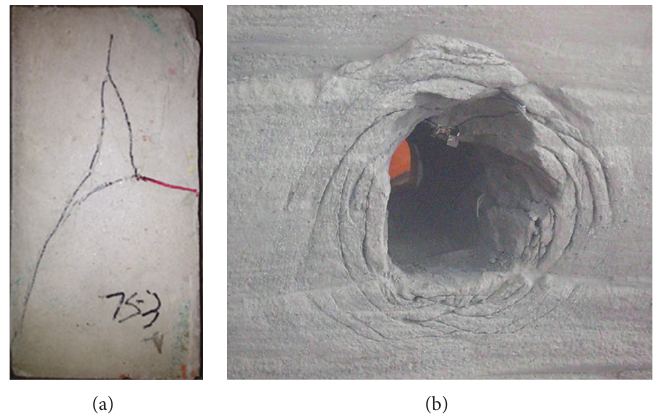
Figure 8: The comparison of the results between this paper and the